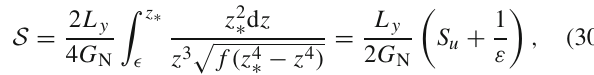
Substituting Eq. (28) into Eq. (27) and using the RT formula (1). We can get the total HEE